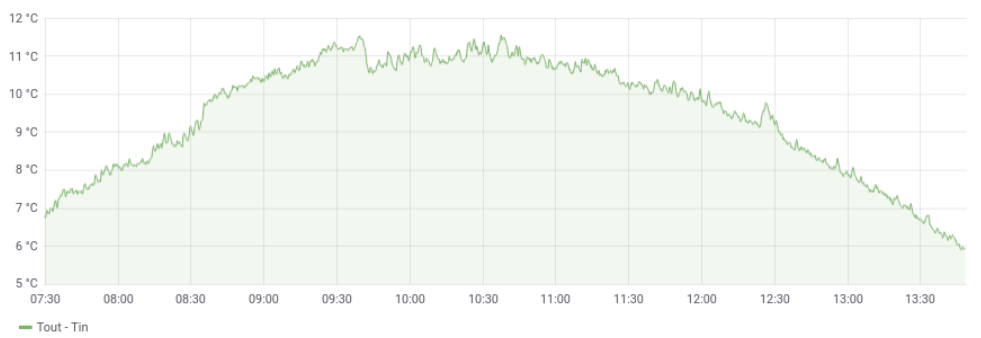
Figure 10. Water outlet–water inlet temperature difference ( T out − T in ) .